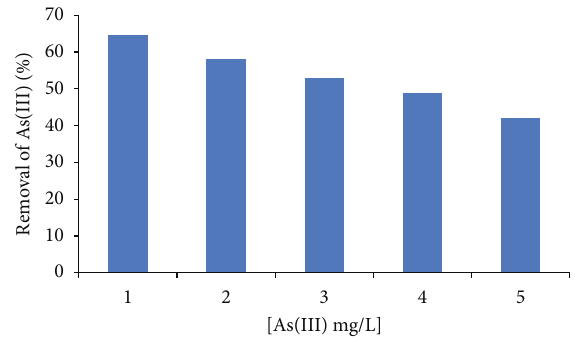
Figure 2: The effect of the Incubation time of As(III). 1mg/L As(III), 30 ∘ C, 100rpm, pH 6.0, 1g of iron-coated fungal biomass of Paecilomyces sp.